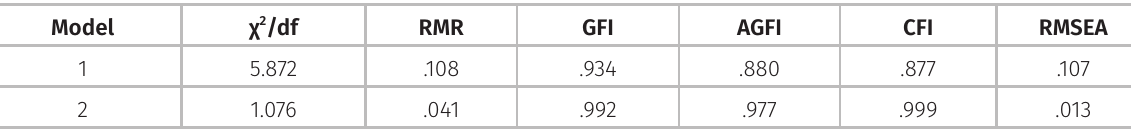
Table III. Measures of fit for